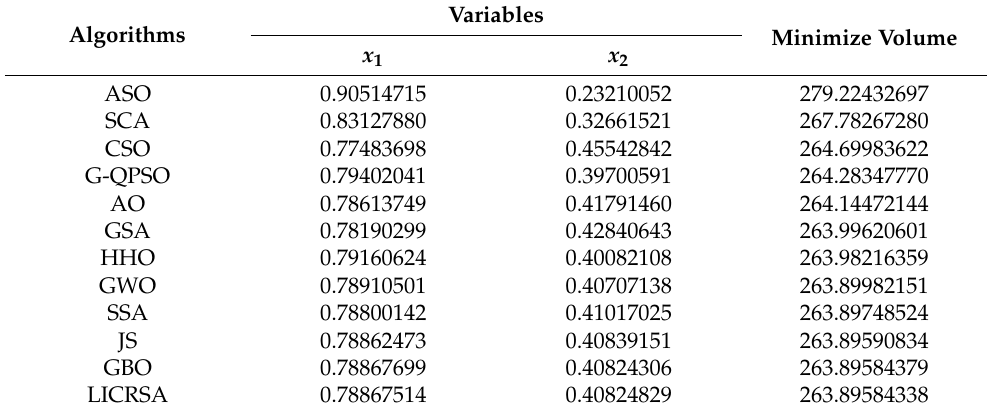
Table 13. Results for the three-bar truss design.